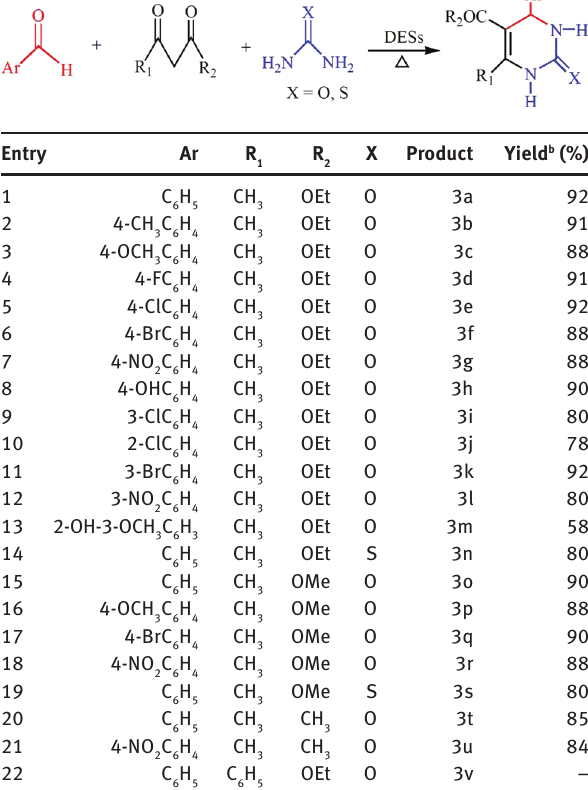
Table 1: Optimization of the reaction conditions with ChCl/2PTAS as catalyst and solvent. a